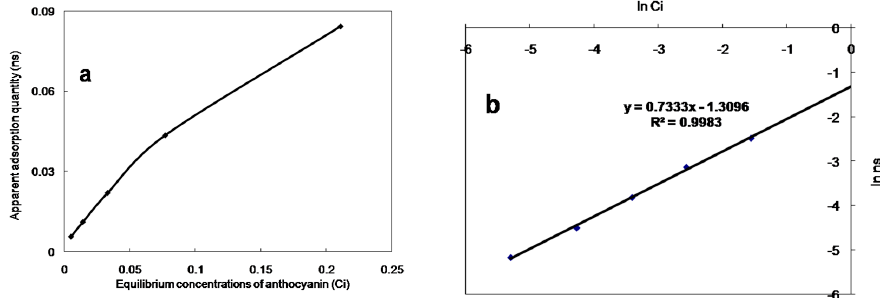
Figure 3. Langmuir adsorption isotherms ( a ) and Freundlich adsorption isotherms ( b ) of S. chinensis anthocyanins on HPD-300 resin.